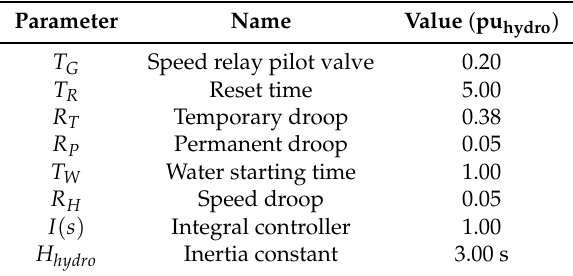
Table 2. Hydro-power plant parameters [62].